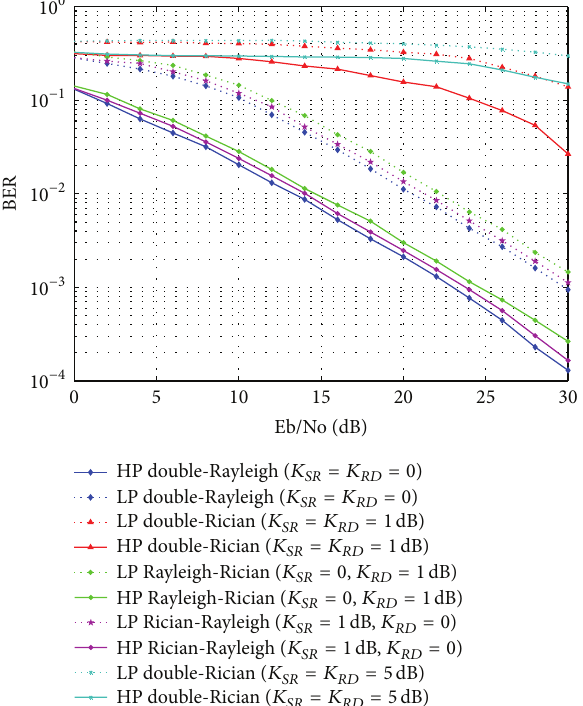
Figure 5: BER for increasing the strength of the LoS component at the 𝑆 - 𝑅 and 𝑅 - 𝐷 subsystems.